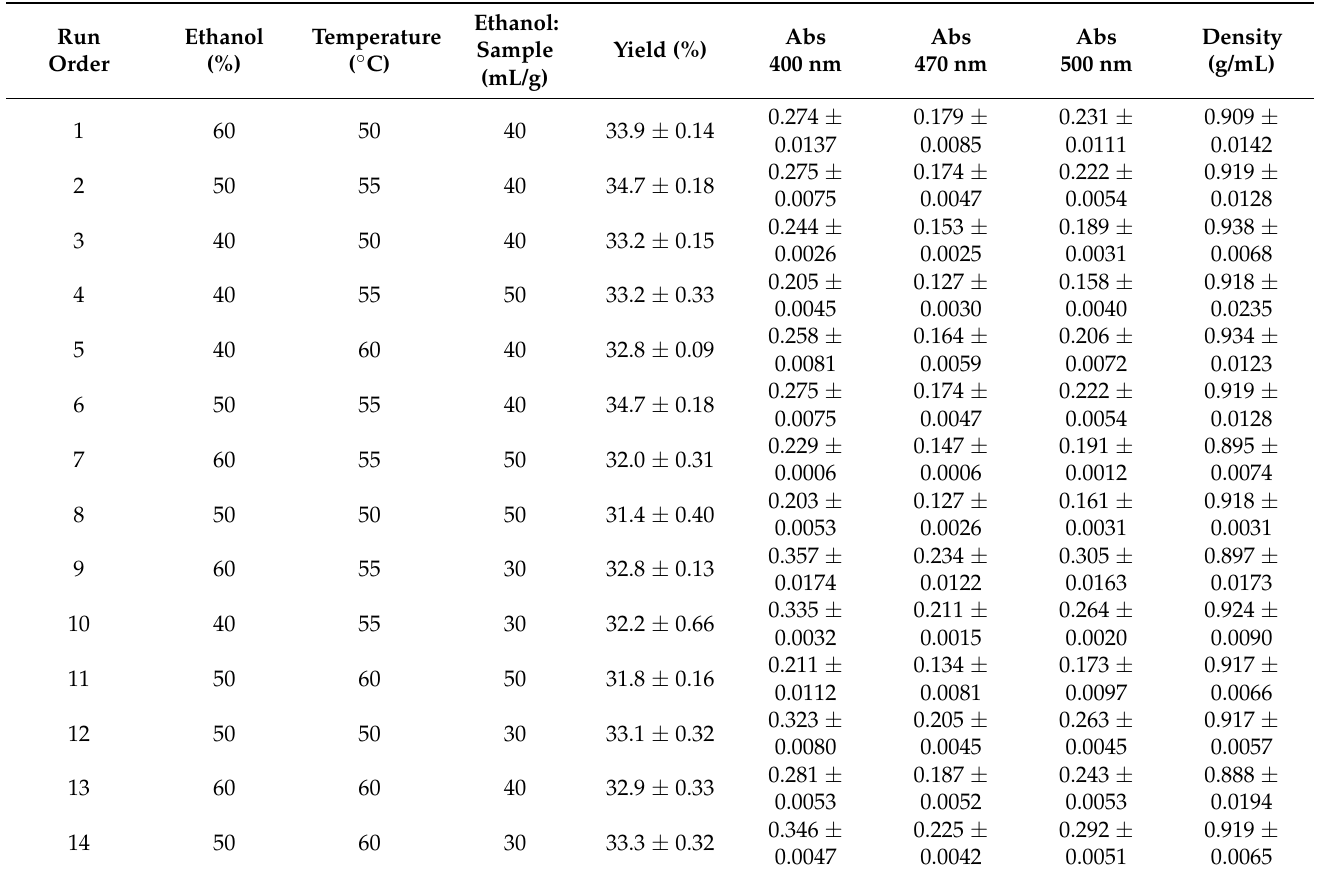
Table 1. The mean yield, density and absorbances of hydroethanolic extracts produced in a Box- Behnken design for three factors: Ethanol (%), Temperature ( ◦ C) and Ethanol: Sample ratio (mL:g) for the pigment extraction from quinoa flour fermented by Monascus purpureus supplemented with fish hydrolysate and sodium